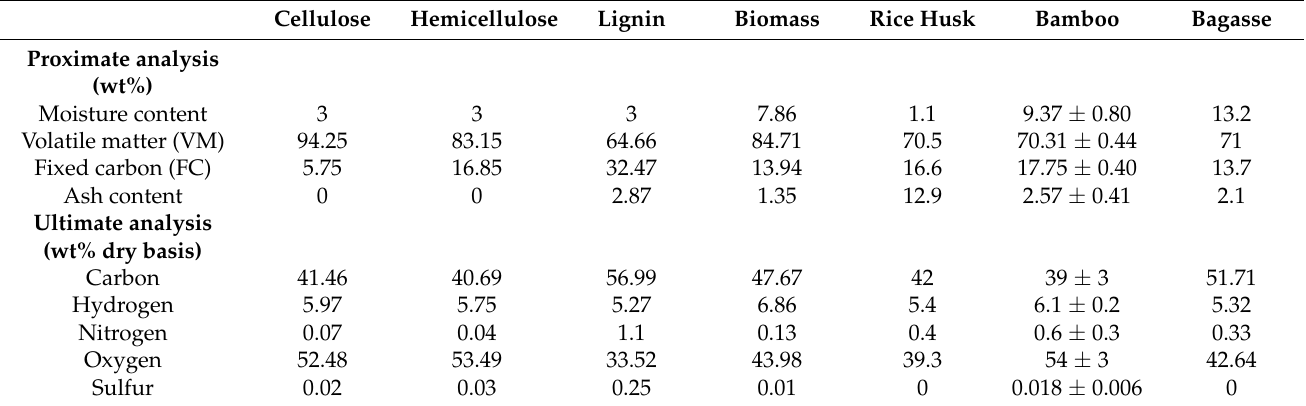
Table 3. Analysis of feedstocks utilized within different TE models [33,41,61–63]. Cellulose